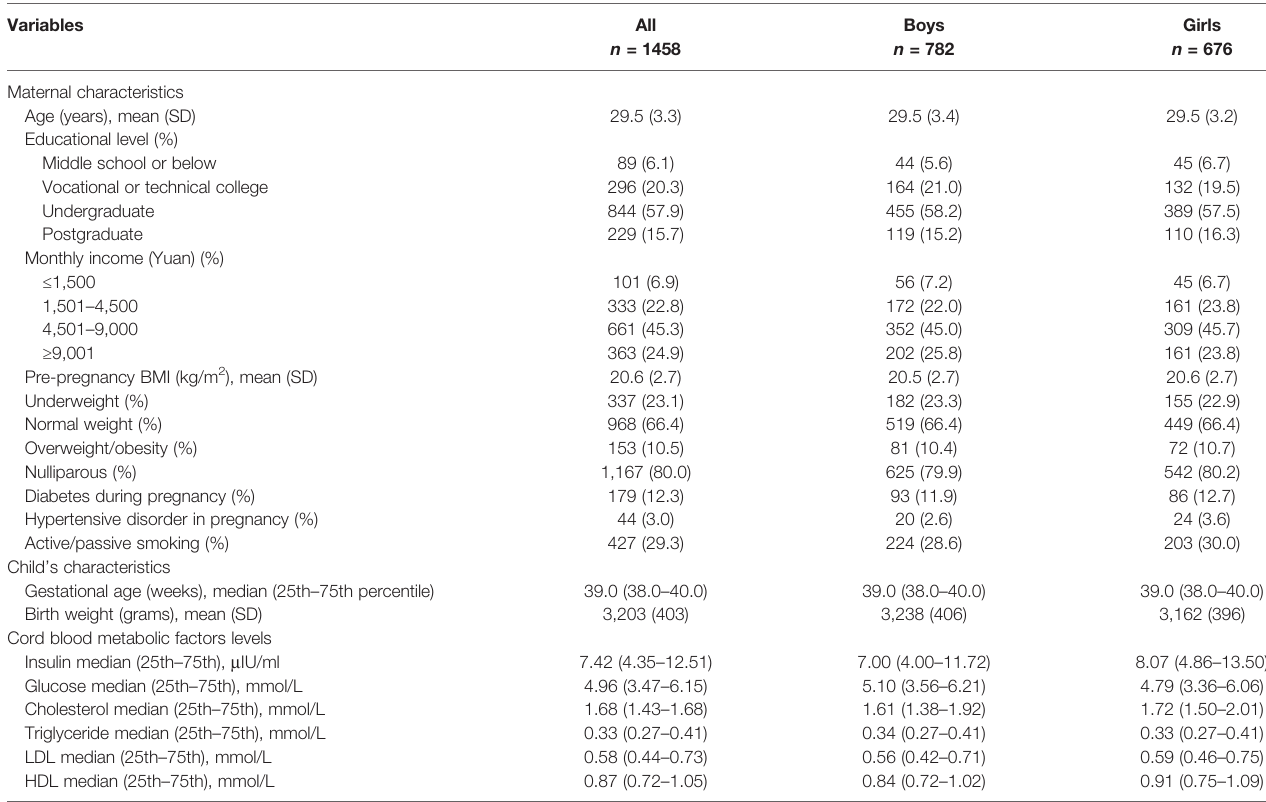
TABLE 1 | Characteristics of the study population.